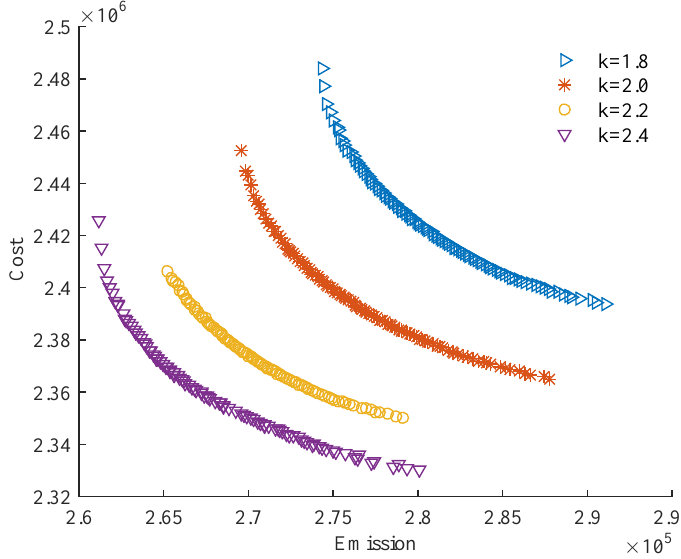
Figure 17. PFs obtained by different shape factors. Table 7. Compromise dispatching schemes obtained for different shape factors.